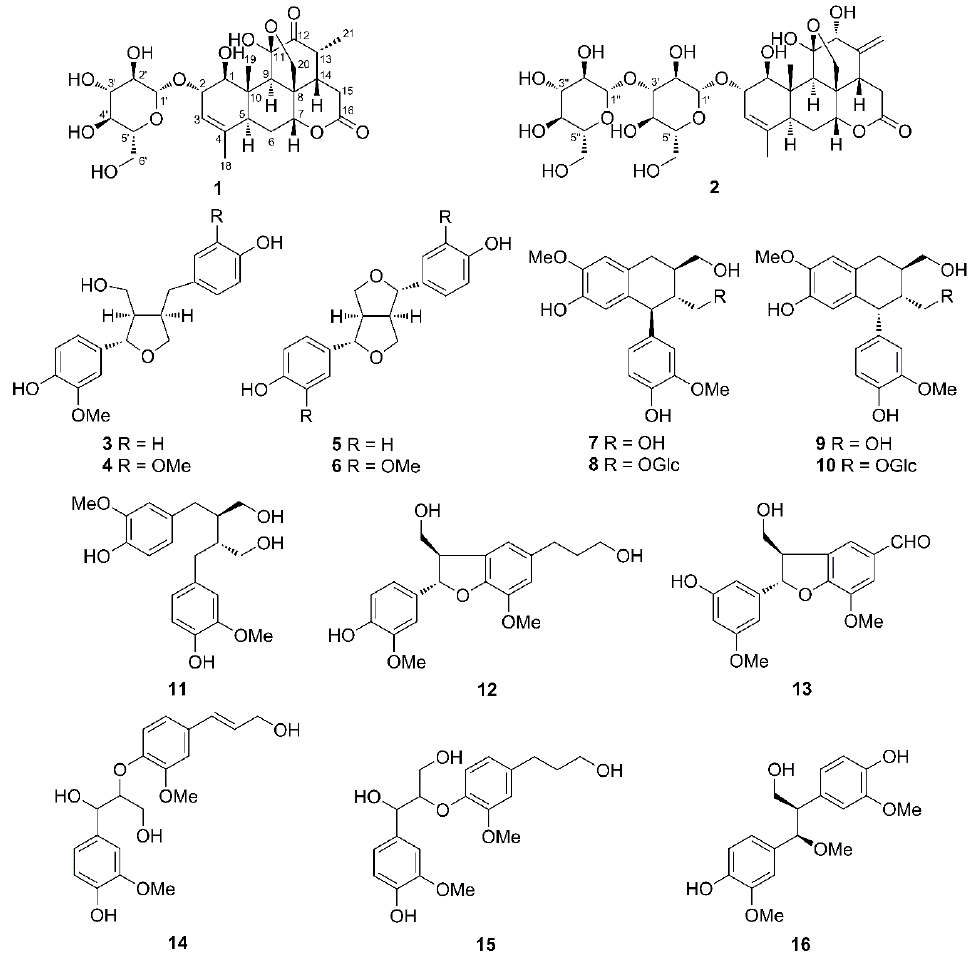
Figure 1. Chemical structures of compounds 1 – 16 .